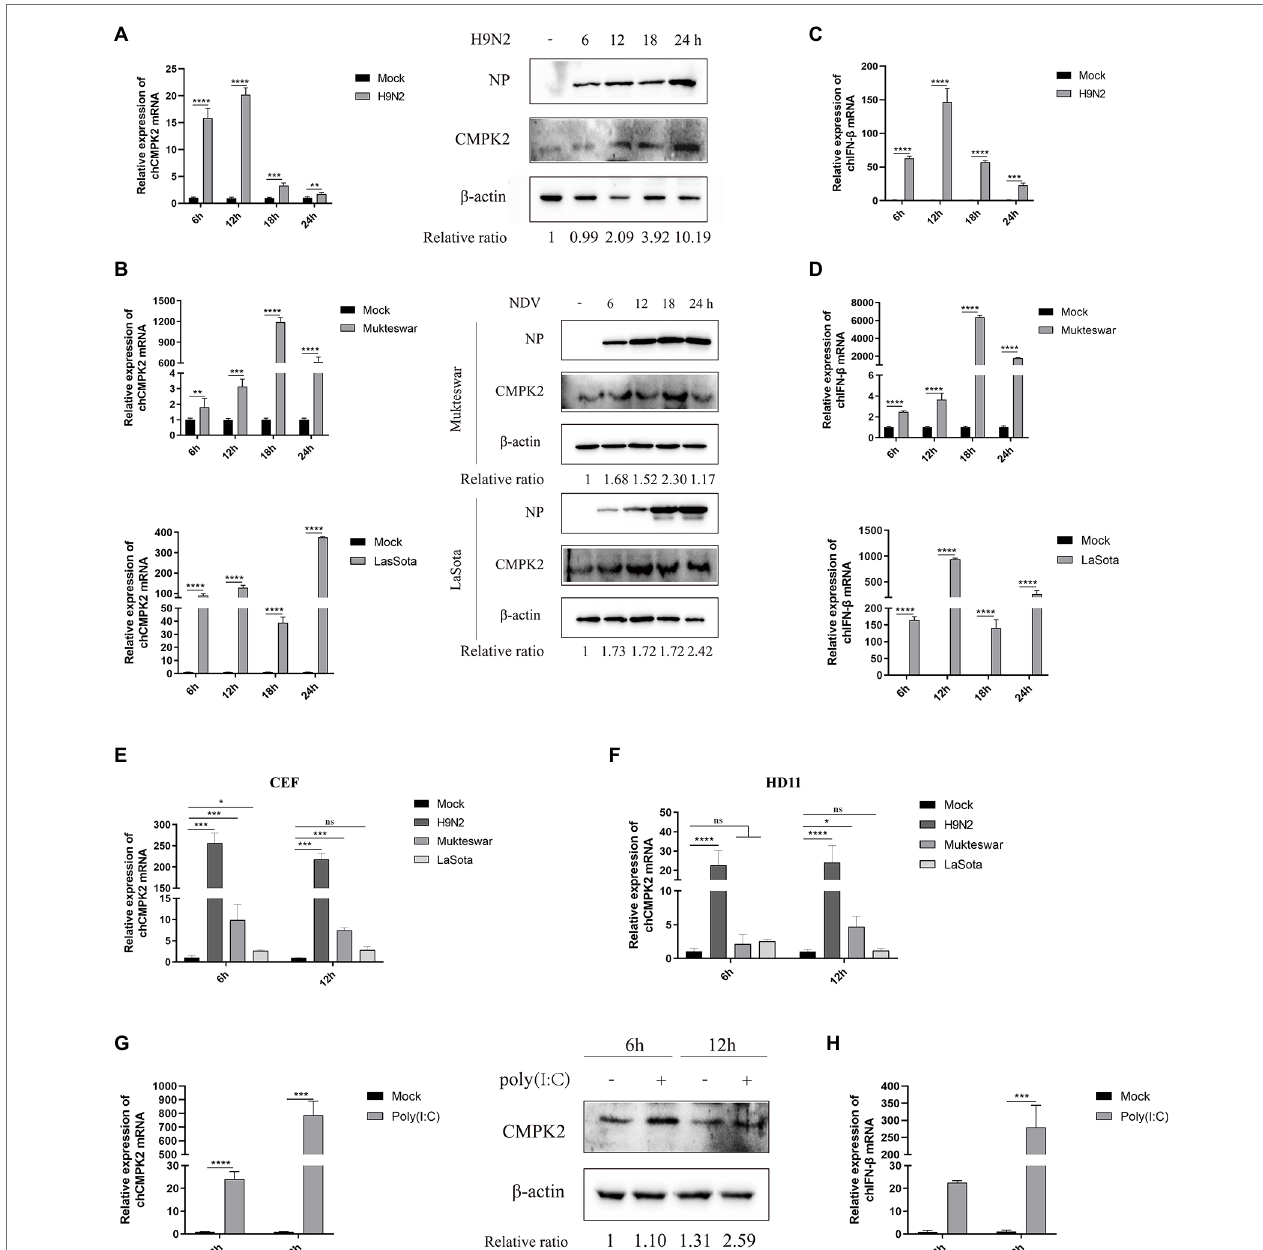
FIGURE 4 | Viral infection induces chCMPK2 expression in vitro . (A) DF-1 cells were infected with H9N2 for 6, 12, 18, and 24 h and the mRNA and protein expression of CMPK2 were detected, as well as the expression of IFN- β was detected by qRT-PCR (C) . (B) DF-1 cells were infected with NDV Mukteswar and LaSota strains for 6, 12, 18, and 24 h and the mRNA and protein expression of CMPK2 were detected, as well as the expression of IFN- β was detected by qRT- PCR (D) . (E,F) HD11 cells, and CEFs were infected with AIV H9N2 and NDV Mukteswar, LaSota strains at an MOI of 1 for 6 and 12 h, and then the expression of CMPK2 was detected by qRT-PCR. (G) DF-1 cells were treated with poly(I:C) at a concentration of 1 μ g/ml for 6 and 12 h, and then the expression of CMPK2 was detected by qRT-PCR and WB while the expression of IFN- β was tested by qRT-PCR (H) . The gray intensity for each band of WB assays was measured, and the relative ratio of CMPK2 was determined from the equation (Sample CMPK2 /Sample actin )/(Mock CMPK2 /Mock actin ) and marked at the bottom of each lane. Values represent the mean of the individual measurements in each sample ± SEM. * p < 0.05, ** p < 0.01, *** p < 0.001, and **** p <